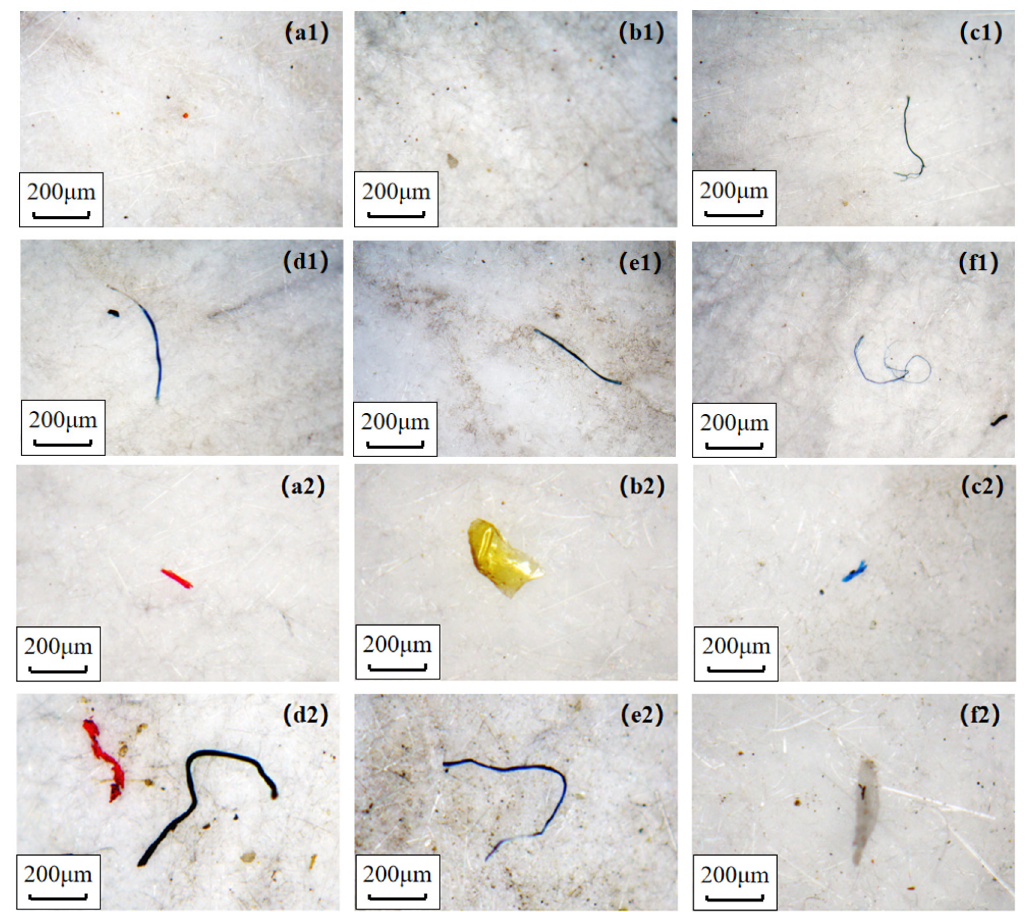
Figure 2. Microplastics detected on GFFs under indoor ( top , a1 – f1 ) and outdoor ( bottom , a2 – f2 ) conditions. ( a – f ): activated-carbon mask (AC), N95 mask (N95), surgical mask (SU), cotton mask (CO), fashion mask (FA), without mask (AIR), respectively.